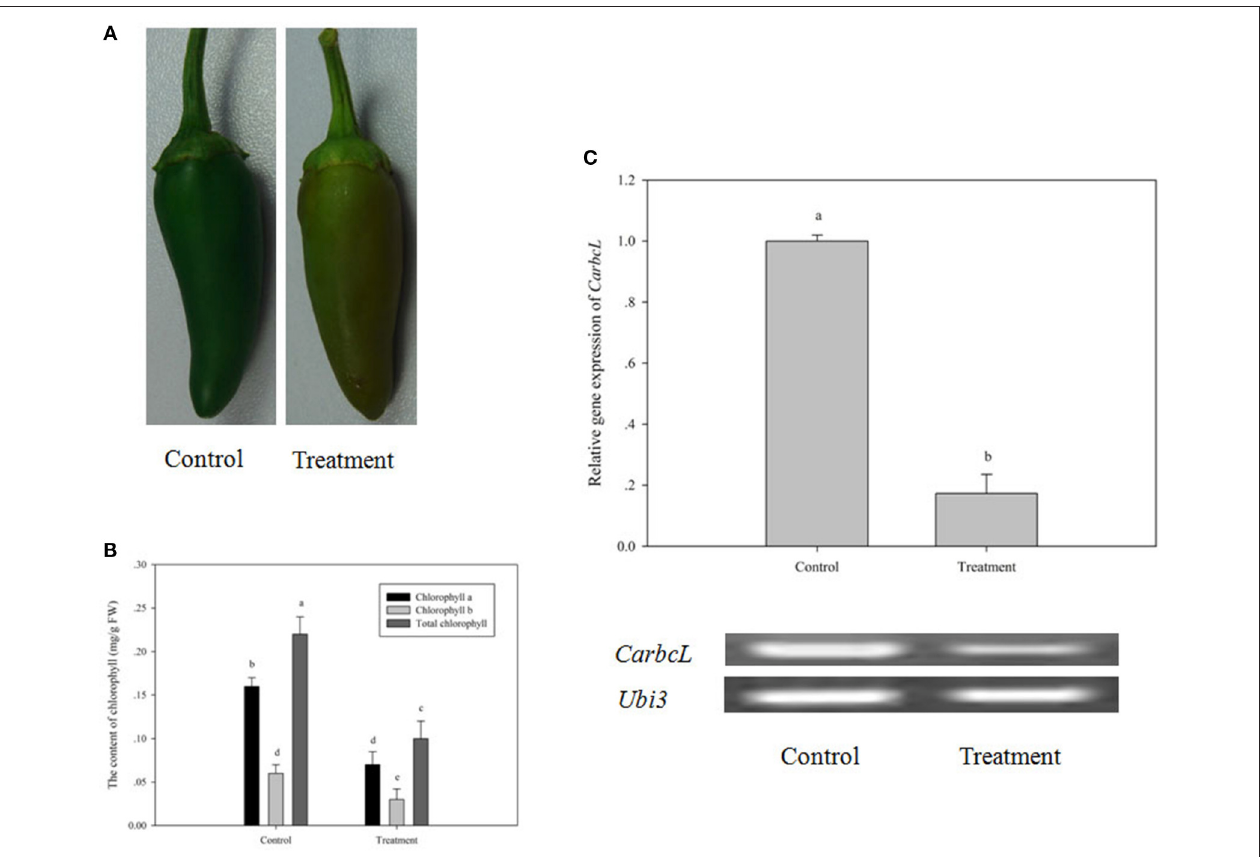
FIGURE 6 | Changes in fruit phenotype, chlorophyll content and CarbcL gene expression under low light. (A) Phenotypic differences in fruits of the control and treatment groups. (B) Differences in the chlorophyll content of fruits in the control and treatment groups. (C) Gene expression differences in fruits of the control and treatment groups; Control: the control group (Fruits with no shade stress), Treatment: the treatment group (Fruits with shade stress). LSR analysis at 5% is shown in lowercase letters (a and b). Means with the same letter are not significantly different. All experiments were carried out in